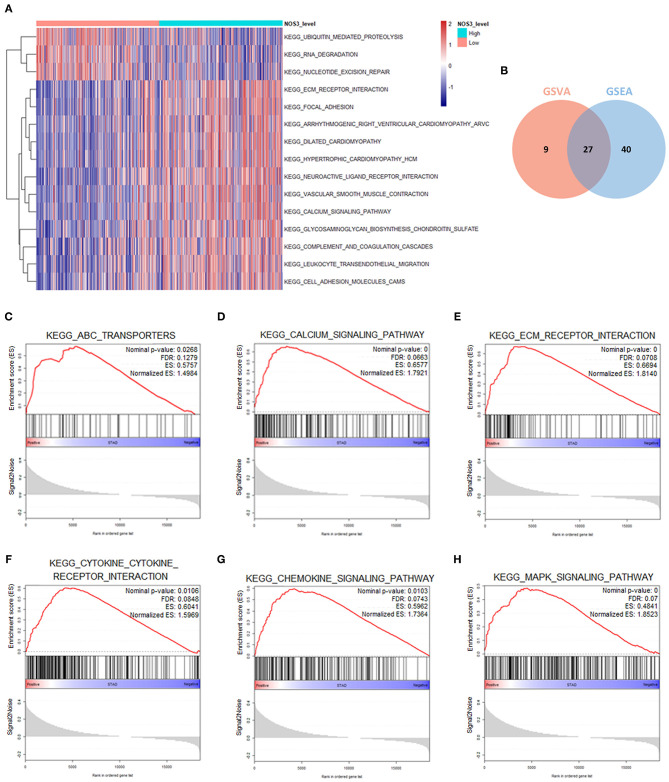
GSEA and GSVA analyses in STAD. (A) Top 15 differentially enriched KEGG signaling pathways in higher and lower NOS3 expression groups analyzed by GSVA in STAD. (B) Seven signaling pathways commonly enriched by GSEA and GSVA in STAD. (C–H) Signaling pathways enriched by GSEA analyses in STAD.